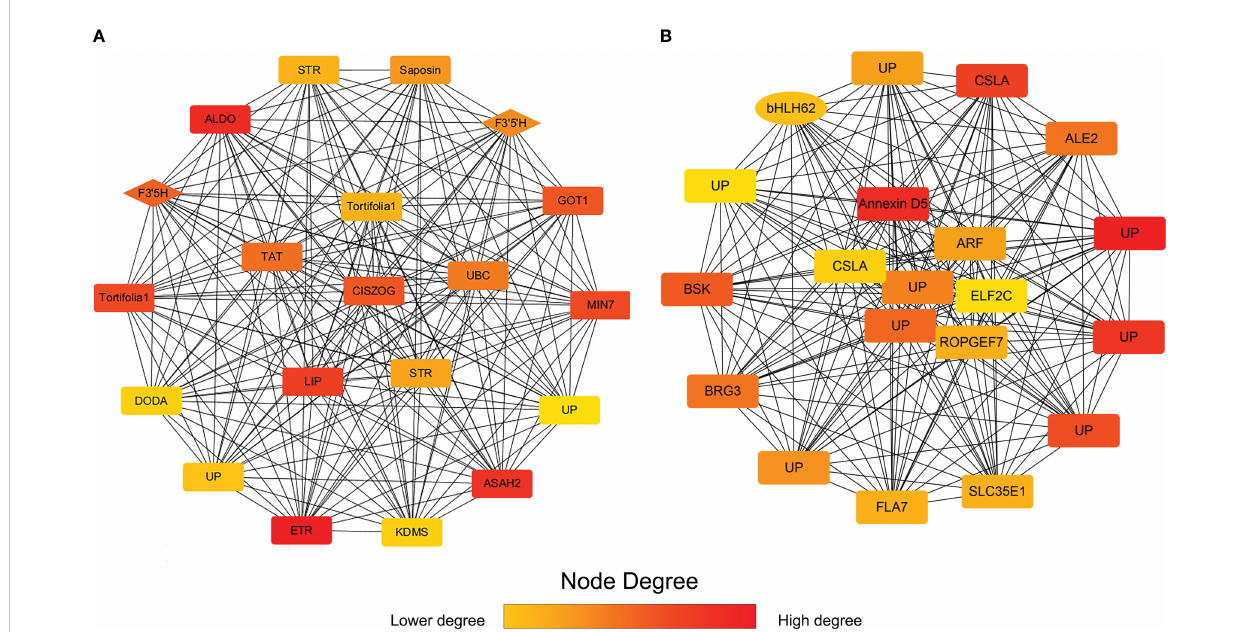
FIGURE 7 The fi rst 20 gene networks in darkviolet and biseque4 modules. (A) The fi rst 20 gene network in the darkviolet module. The diamond represents the F3 ′ 5 ′ H gene. (B) The fi rst 20 gene network in the bisque4 module. Ellipse represents the bHLH transcription factor. The more forward ranking is represented by a redder